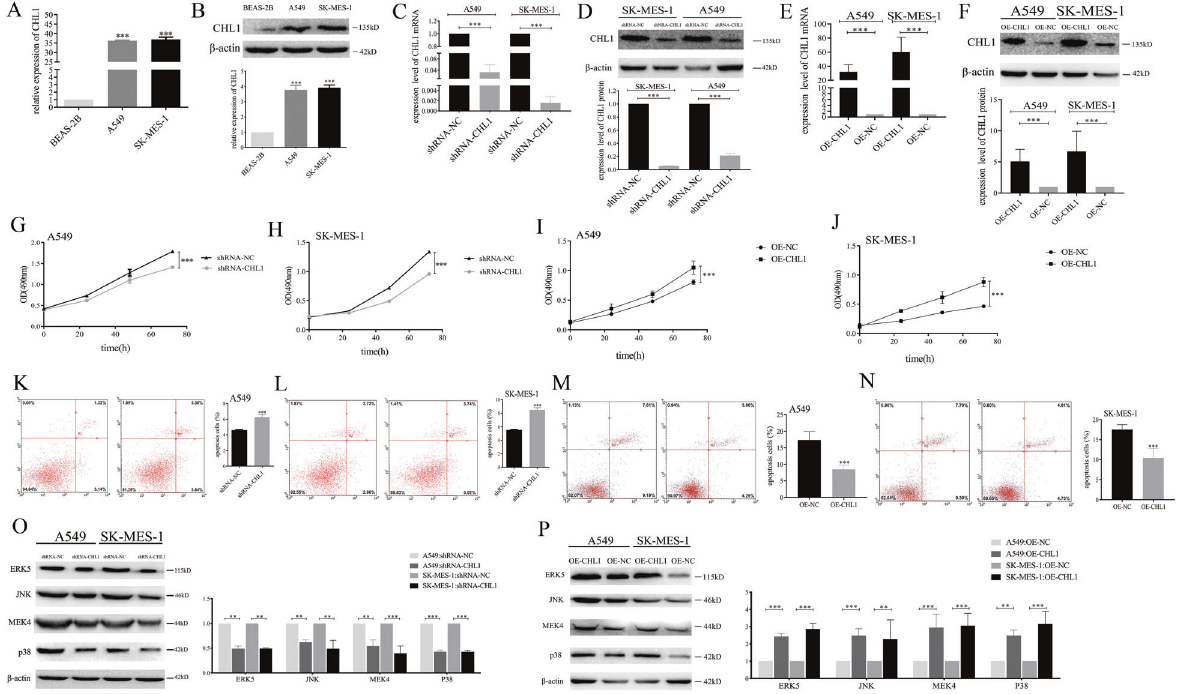
Fig. 2 CHL1 promotes the proliferation and suppresses apoptosis of NSCLC cells by activating MAPK signaling pathway. A The expression level of CHL1 mRNA in BEAS-2B, A549, and SK-MES-1 cells. B The expression level of CHL1 protein in BEAS-2B, A549, and SK-MES-1 cells. C The expression level of CHL1 mRNA in A549 and SK-MES-1 cells with the treatment of shRNA-NC and shRNA-CHL1. D The expression level of CHL1 protein in A549 and SK-MES-1 cells with the treatment of shRNA-NC and shRNA-CHL1. E The expression level of CHL1 mRNA in A549 and SK- MES-1 cells with the treatment of OE-NC and OE-CHL1. F The expression level of CHL1 protein in A549 and SK-MES-1 cells with the treatment of OE-NC and OE-CHL1. G MTS assay for the growth of A549 cells with the treatment of shRNA-NC and shRNA-CHL1 at 0, 24, 48, and 72 h. H MTS assay for the growth of SK-MES-1 cells with the treatment of shRNA-NC and shRNA-CHL1 at 0, 24, 48, and 72 h. I MTS assay for the growth of A549 cells with the treatment of OE-NC and OE-CHL1 at 0, 24, 48, and 72 h. J MTS assay for the growth of SK-MES-1 cells with the treatment of OE-NC and OE-CHL1 at 0, 24, 48, and 72 h. K Apoptotic assay for A549 cells with the treatment of shRNA-NC and shRNA-CHL1. L Apoptotic assay for SK-MES-1 cells with the treatment of shRNA-NC and shRNA-CHL1. M Apoptotic assay for A549 cells with the treatment of OE-NC and OE-CHL1. N Apoptotic assay for SK-MES-1 cells with the treatment of OE-NC and OE-CHL1. O The expression levels of the MAPK signaling pathway downstream molecules with the treatment of shRNA-NC and shRNA-CHL1. P The expression levels of the MAPK signaling pathway downstream molecules with the treatment of OE-NC and OE-CHL1. ** P < 0.01, *** P < control group. However, no differences were observed between the control group and the blank group. Then we found that the Table 2 listed, the exosomal miR-338-3p expression was signi fi - cantly associated with pathological classi fi cation ( P < 0.001), M decreased (Fig. 6F: P < 0.001), proving the above hypothesis that BEAS-2B cells could transfer exosomal miR-338-3p to A549 cells